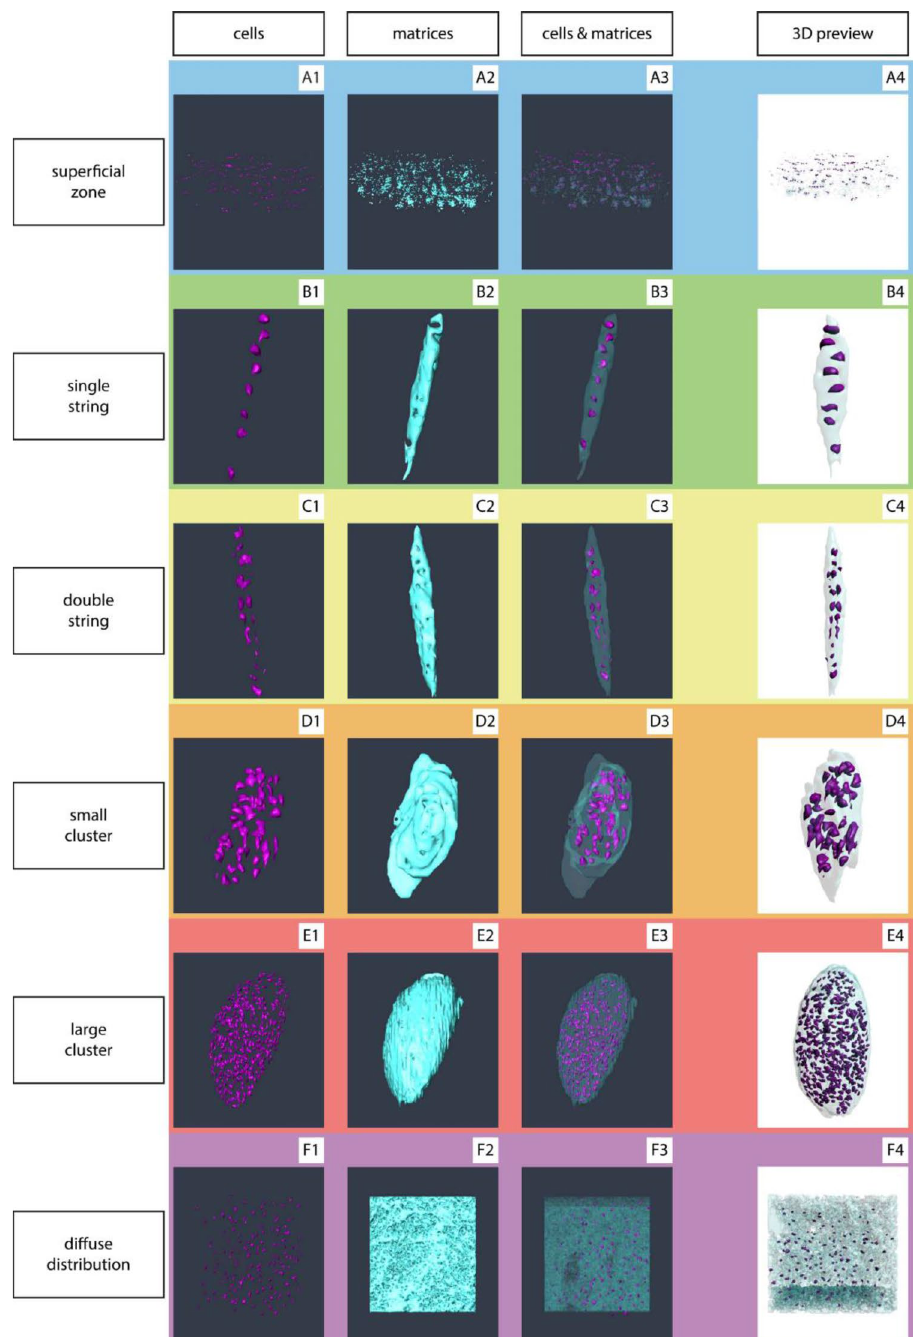
Figure 1. Spatial chondrocyte patterns imaged by µCT. Nuclei are depicted in purple (1), the extranuclear space within the lacuna/chondron is shown in light blue (2). (3) Showing the merged spatial patterns, and (4) the interactive 3D reconstructions of the different spatial patterns. In case of a diffuse cellular distribution, no lacuna/chondron is present any longer but instead the extracellular matrix is depicted. This figure was created using Amira 6.0 (https:// www. therm ofish er. com/ ch/ en/ home/ indus trial/ elect ron- micro scopy/ elect ron- micro scopy- instr uments- workf ow- solut ions/ 3d- visua lizat ion- analy sis- softw are/ amira- life- scien ces- biome dical. html), MeVisLab (https:// www. mevis lab. de/ mevis lab) and Adobe Illustrator CS6 (https:// www. adobe. com/ ch_ de/ produ cts/ illus trator.